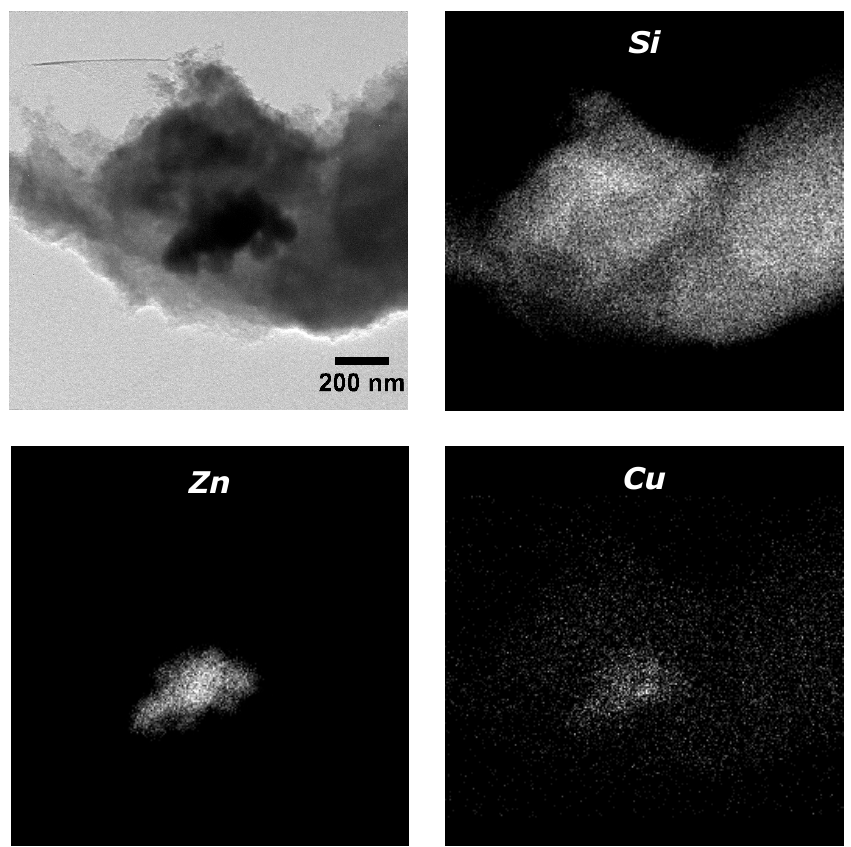
Figure 4. TEM image of a silica aerogel with catalyst and dark field to identify silica (Si), zinc (Zn) and copper (Cu) distribution.